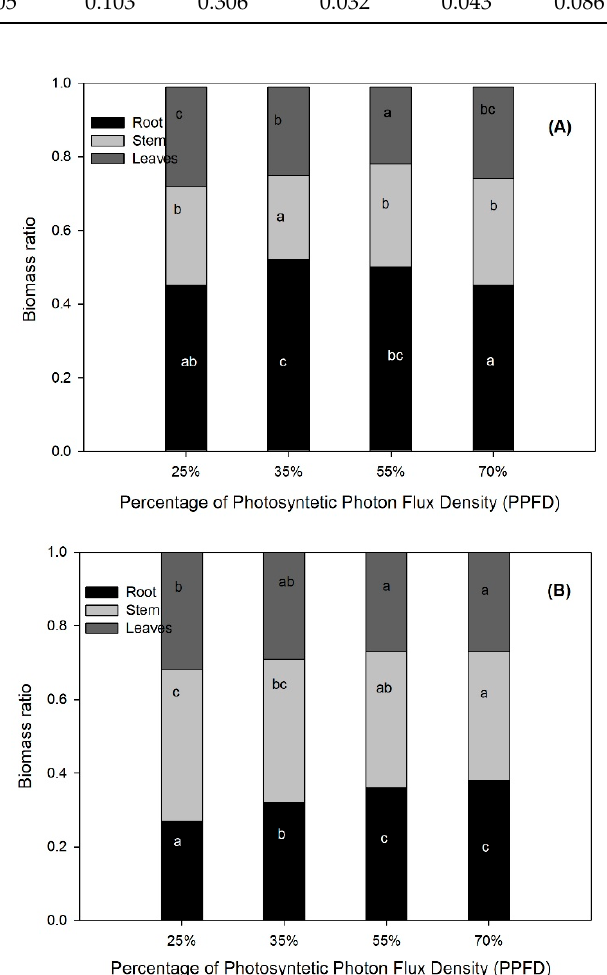
values were obtained in the former with the 35% PPFD treatment, and in the latter, with 25% PPDF (Table 1). When comparing these values with the lower values registered by the plants under the 70% PPFD treatment, there was a difference of 23% and 16% for each variable, respectively (Table 1).